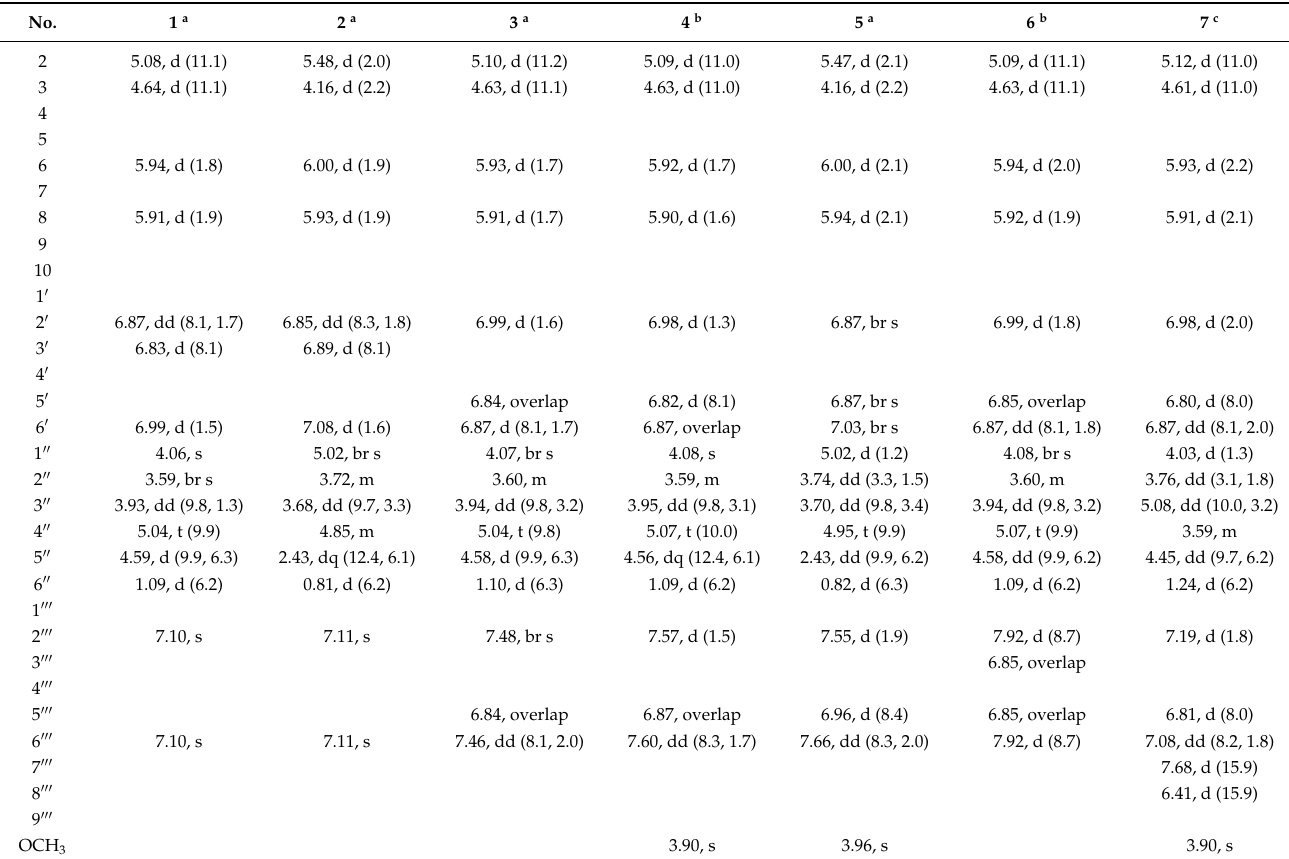
Table 1. 1 H NMR data for compounds 1 – 7 in CD 3 OD ( δ H in ppm, mult. J in Hz).